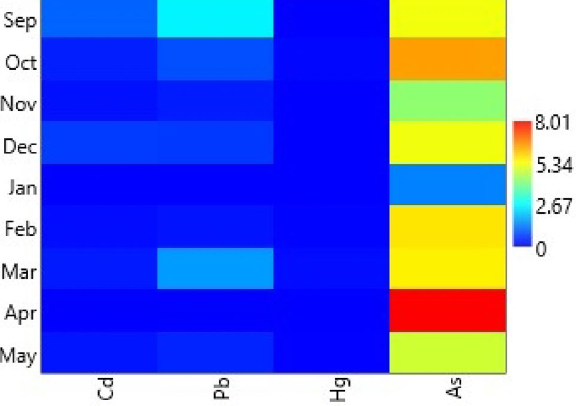
Fig. 2 Range description of heavy metal concentrations and inten- sity are highlighted with distinct colour patterns